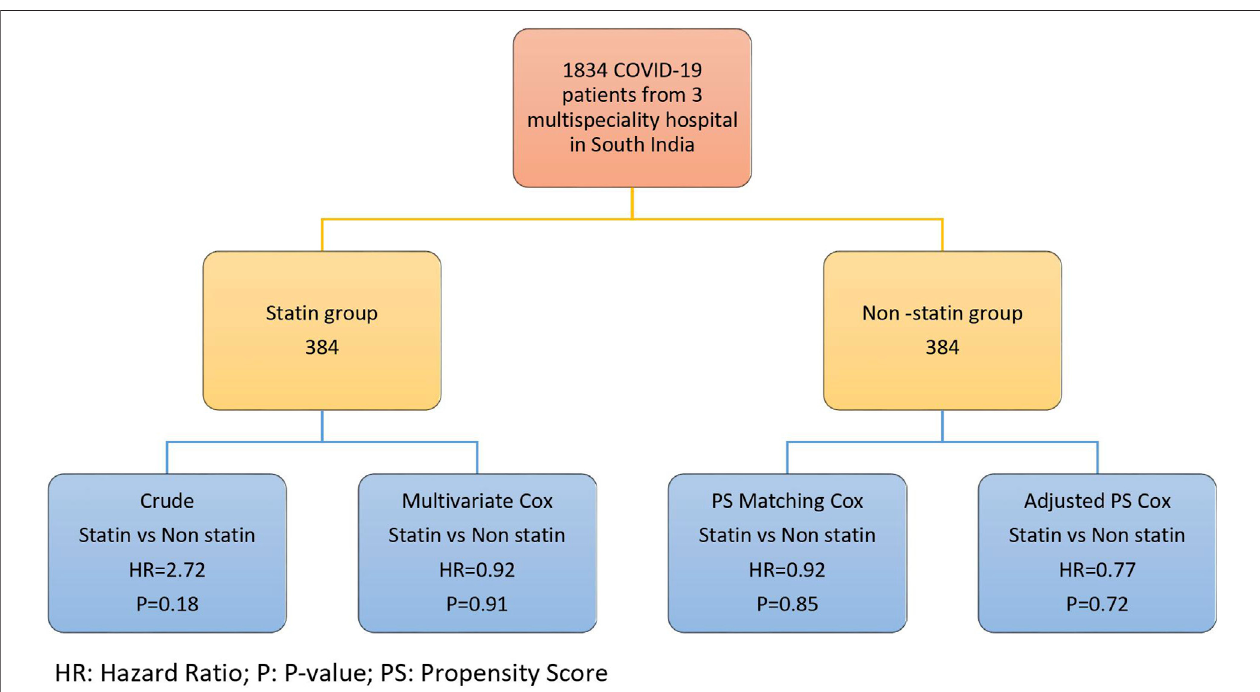
FIGURE 1 | Flow-chart depicting study population and Cox proportional-hazards regression